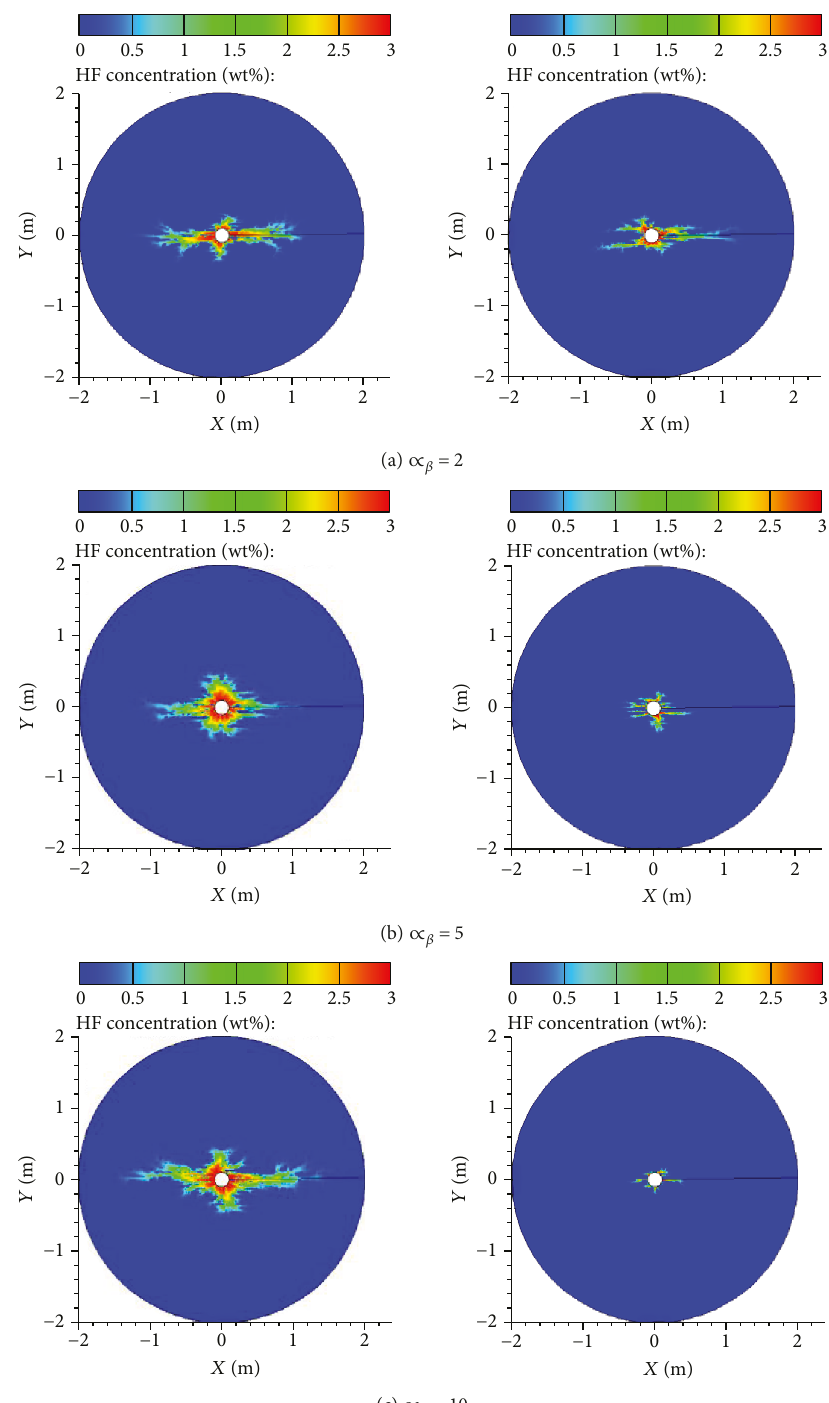
Figure 11: HF distribution in two